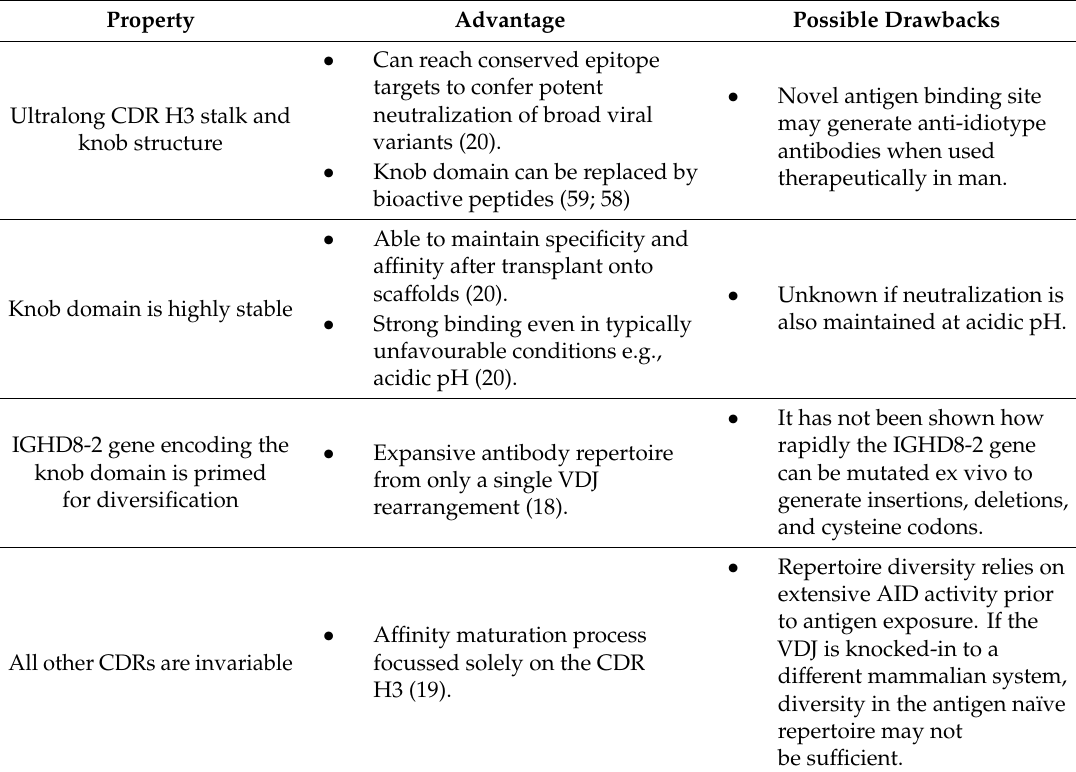
Table 1. Advantages and potential drawbacks of the ultralong CDR H3